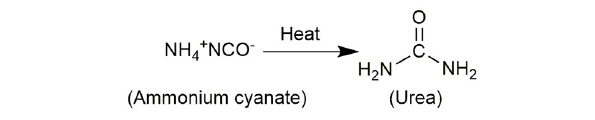
FIGURE 2 | Wohler‘s